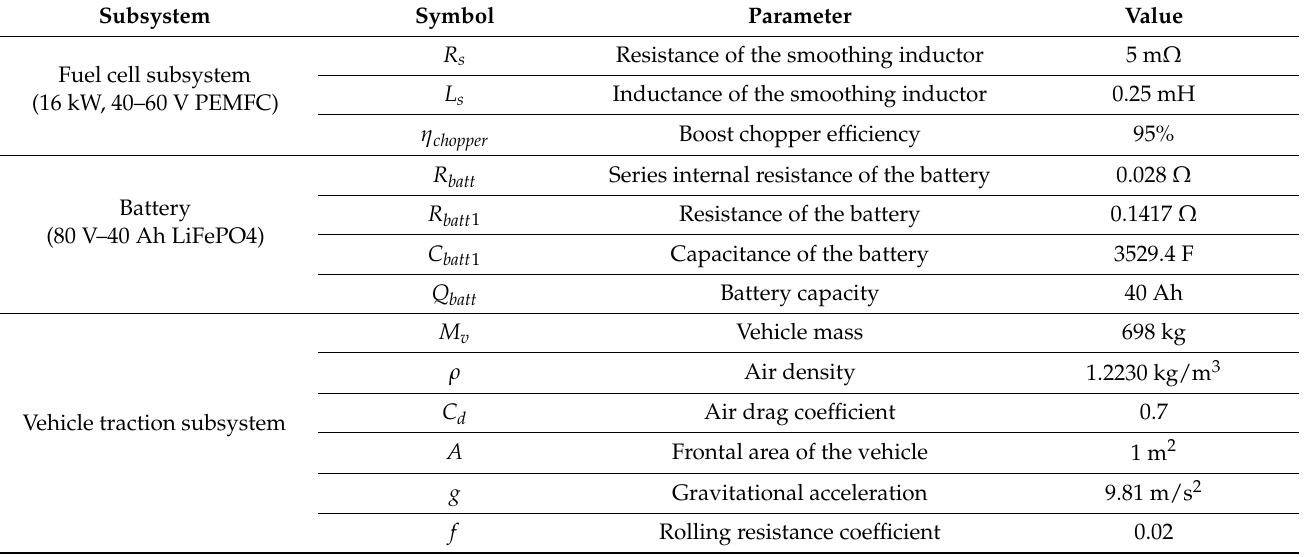
Figure 1. Fuel cell vehicle structure: Thin lines indicate electrical connections, and thick lines indicate mechanical connections. Table 1. Parameters for the fuel cell vehicle model.